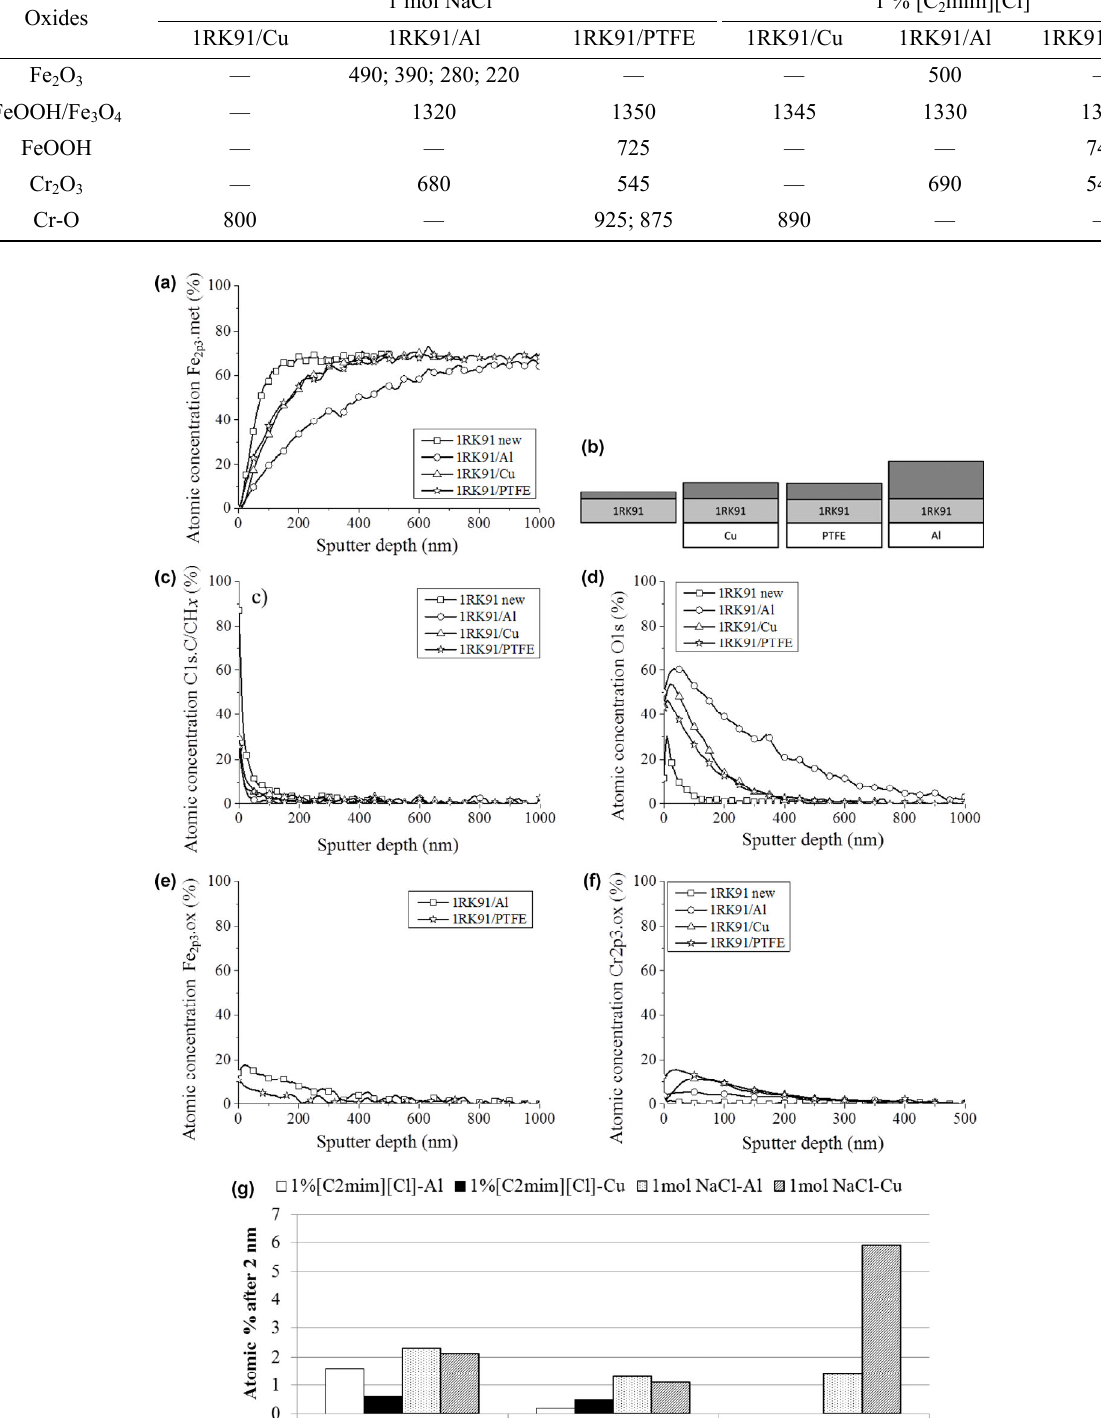
Table 1 Raman signals (cm –1 ) measured in the wear track of the 1RK91 disks after tribotest.